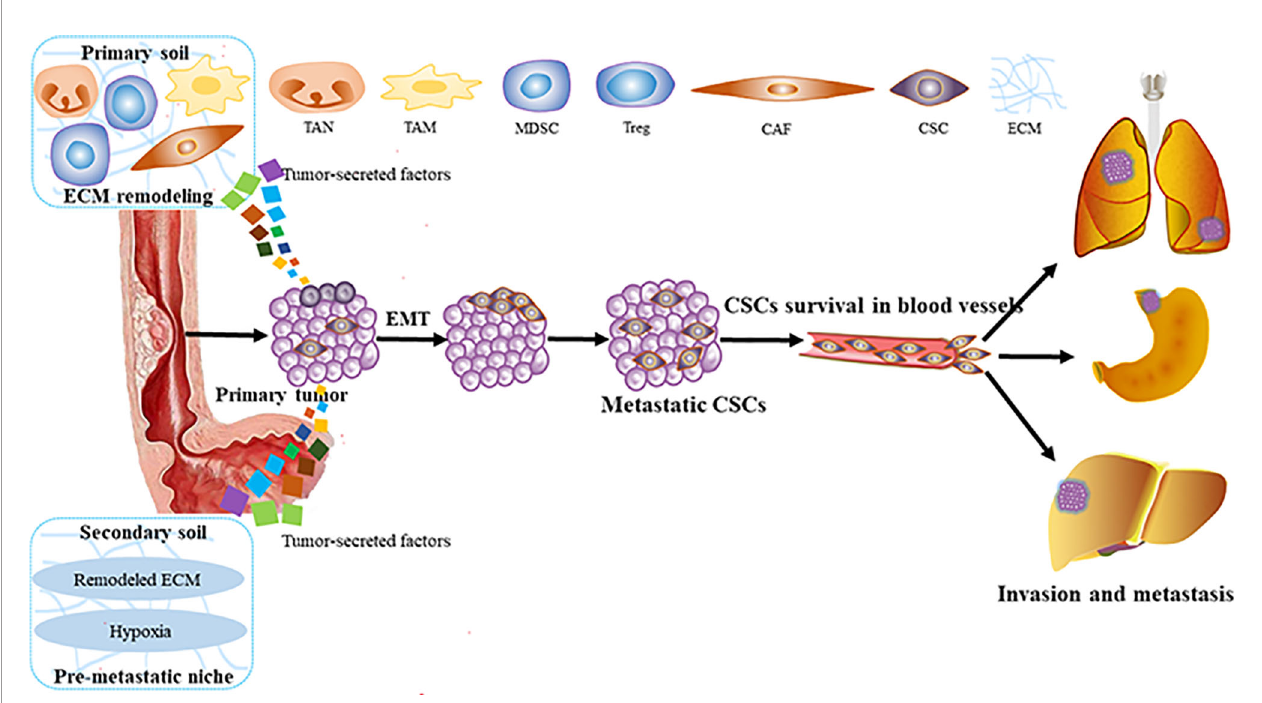
FIGURE 1 | The process of ESCC invasion and metastasis. ESCC, esophageal squamous carcinoma; MDSC, marrow-derived suppressor cell; Tregs, regulatory T cells; CAFS, cancer associated fi broblasts; EMT, epithelial — mesenchymal transition; TAM, tumor-associated macrophage; TAN, tumor-related neutrophil; ECM, extracellular matrix; CSCs, cancer stem